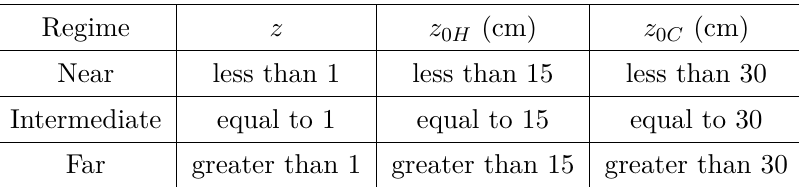
Table 1. Three different regimes in a particular thermodynamical cycle with α H = 6 × 10 17 m/s 2 and α C = 3 × 10 17 m/s 2